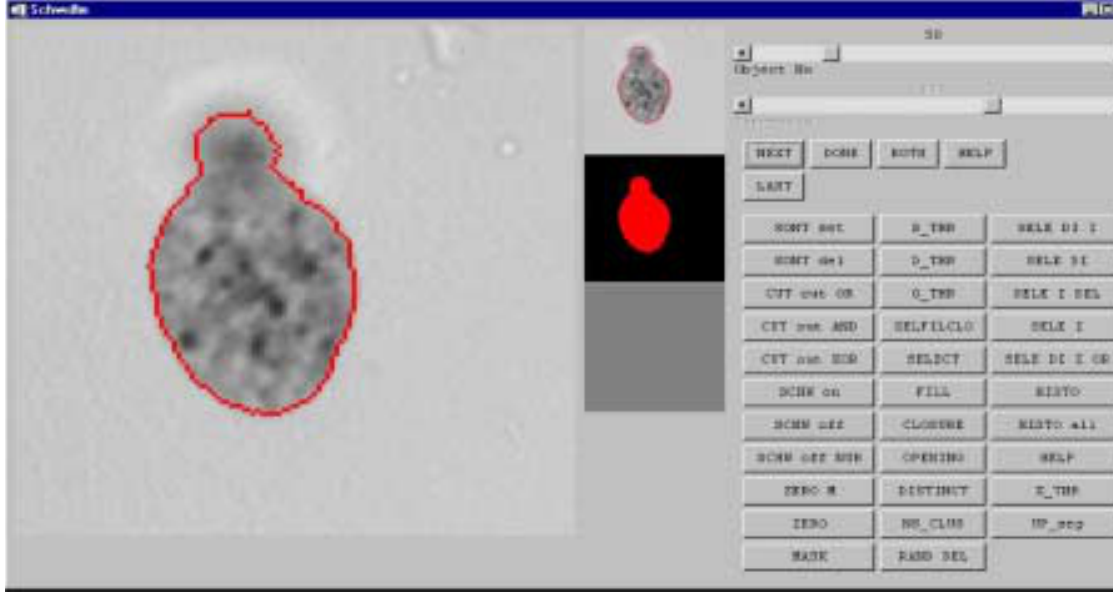
Fig. 4. GUI for segmentation of images. This figure can be viewed on http://www.esacp.org/acp/2003/25-1/rodenacker.htm.